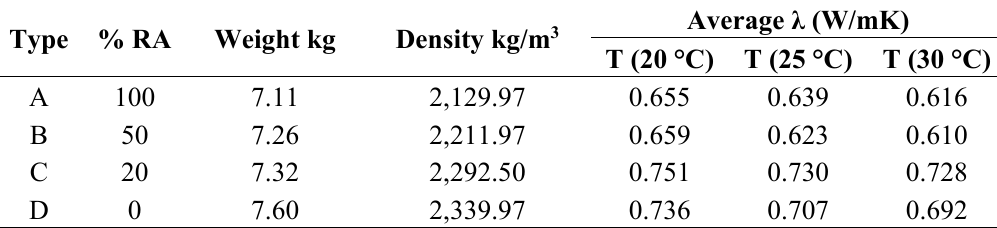
Figure 5. Evolution of the average temperatures of each specimen type. Table 5. Average conductivities at the three temperatures.